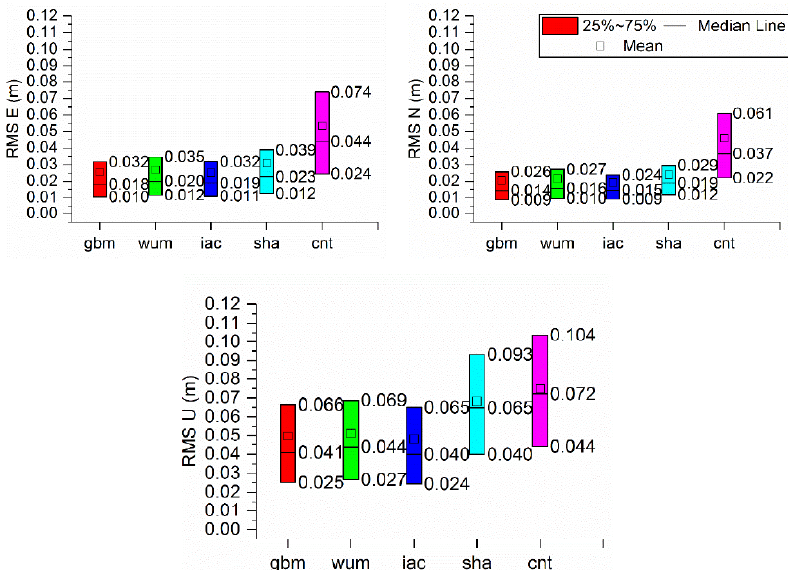
Figure 9. Boxplot of the positioning accuracy in ENU directions derived from BDS-3 PPP in Kinematic mode with different precise